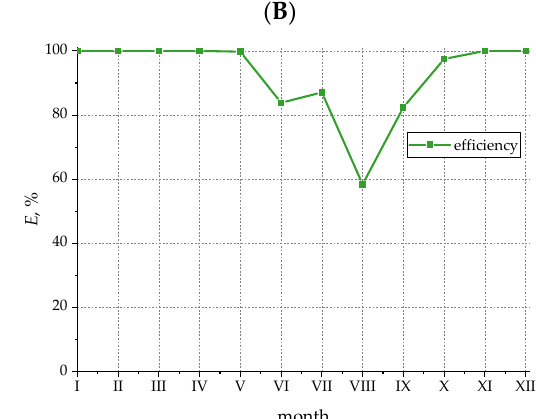
Table 1. Net present value ( NPV) and payback period ( PBP) values related to each tank size for the RWH system.